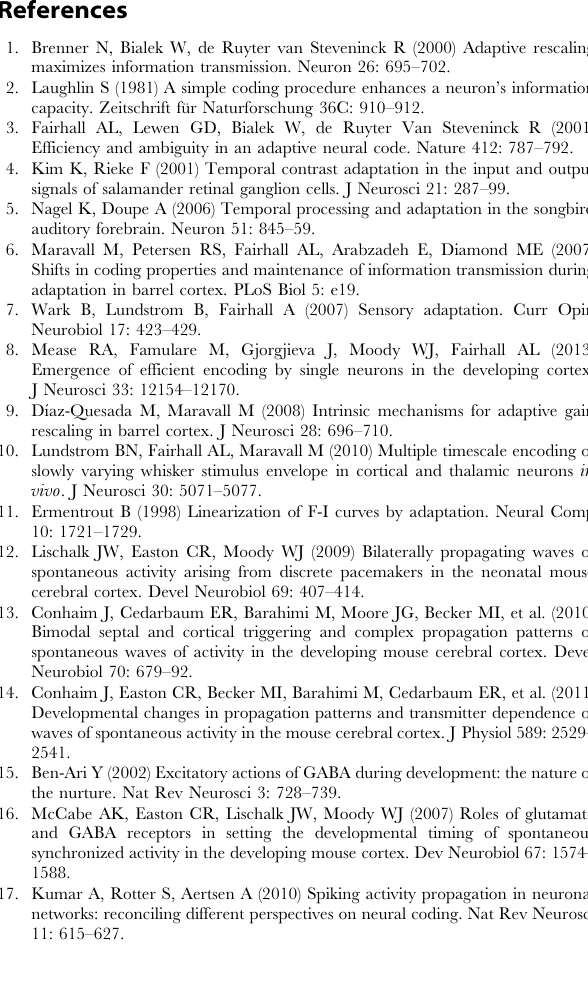
in gray. The remaining panels show the transmission of mean firing rates across layers for a range of mean input currents–each row of panels illustrates the outcome for a different level of noise s . The results from numerical simulations over 10 second-long trials are shown as full lines (mean + s from 2000 neurons in each layer) and mean field predictions are shown in dashed lines with a shaded background in the same color (for each different input) illustrating the standard deviation of the prediction from the standard deviation in the linear input-output relationship in the top panels. Other network parameters: connection probability ~ 0 : 016 (weakly connected) and E ~ 5% , synaptic strength g syn ~ 0 : 1 (strongly connected) and range of mean input firing rates g syn 0–22 (for weakly connected) and 0–70 (for strongly connected). Compare to Figure 6 of the main